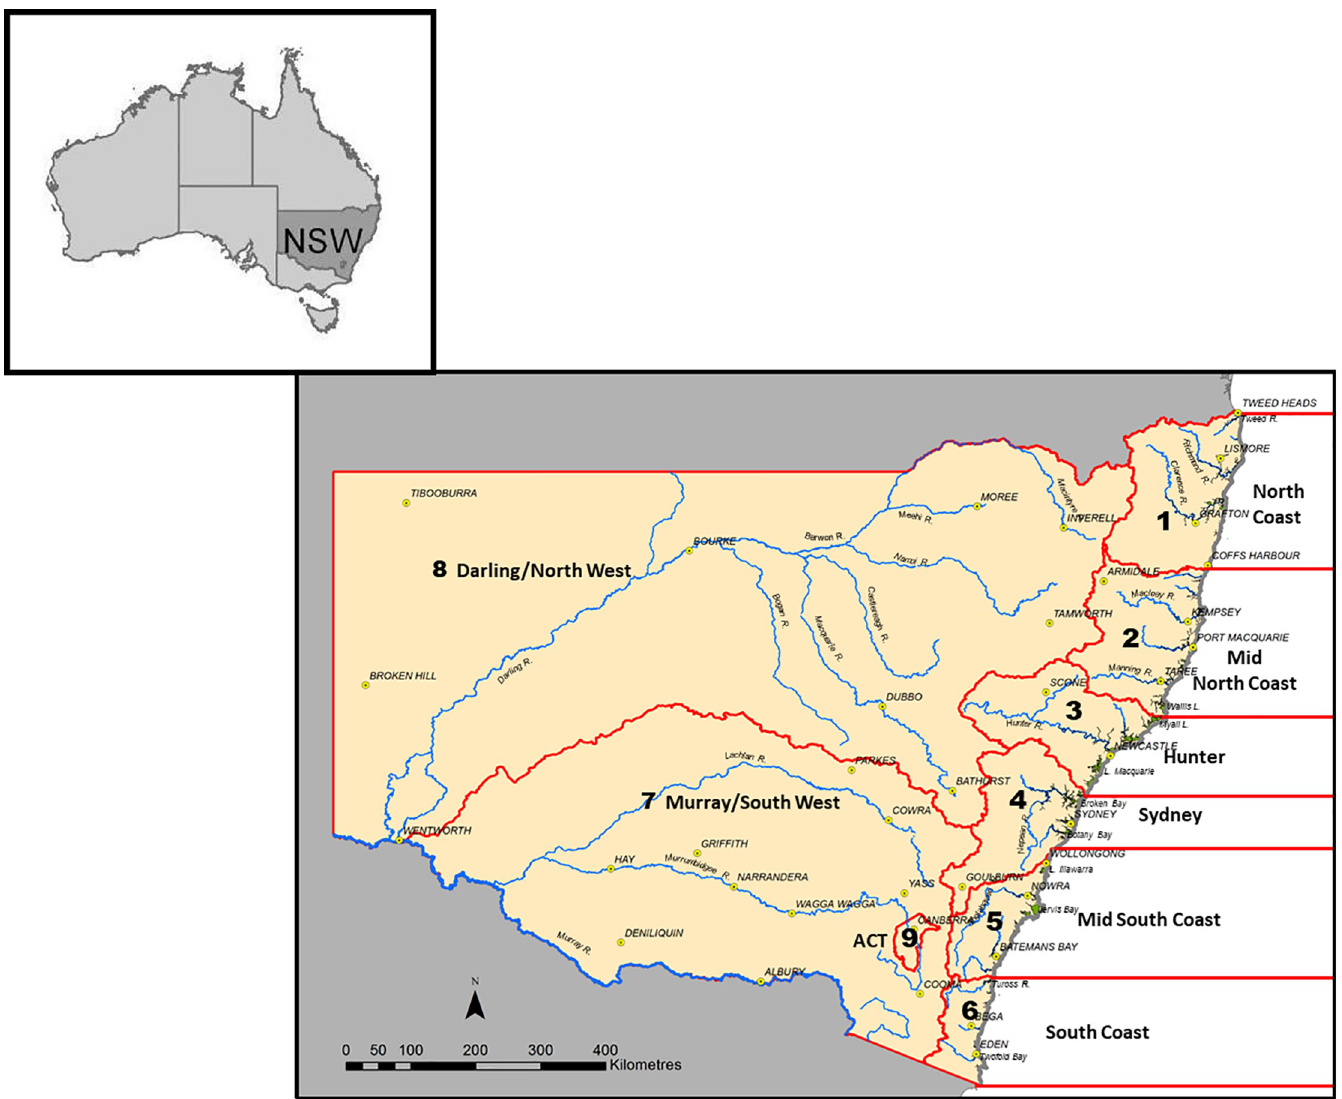
Fig 1. Relative size and location of the different fishing zones in New South Wales (NSW), Australia, including the North Coast, Mid-North Coast, Hunter, Sydney, Mid-South Coast and South Coast. Reprinted from (13) under a CC BY license, with permission from Jeff Murphy (NSW DPI), original copyright 2015.